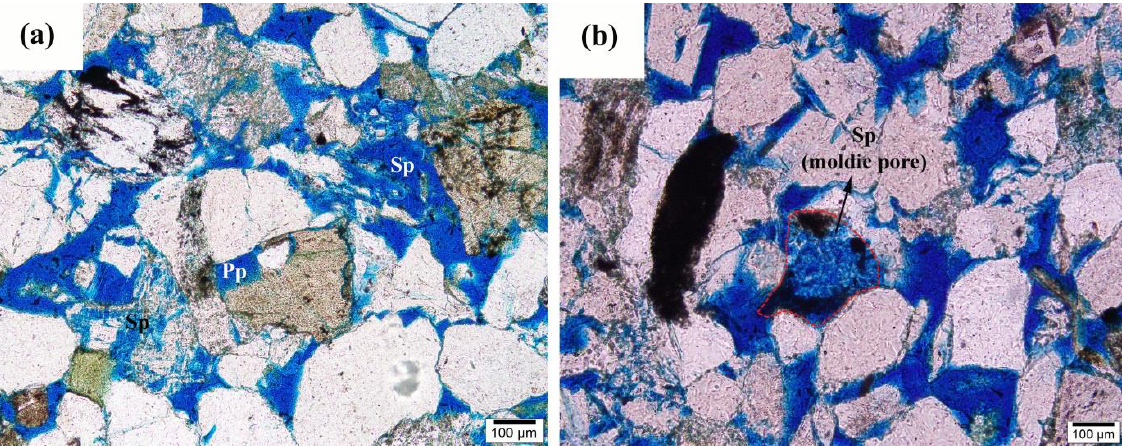
Figure 16. Photomicrographs showing ( a ) partial dissolution and oversized pore at 3182 m depth; ( b ) secondary porosity (Sp) (moldic) at 3181 m depth.